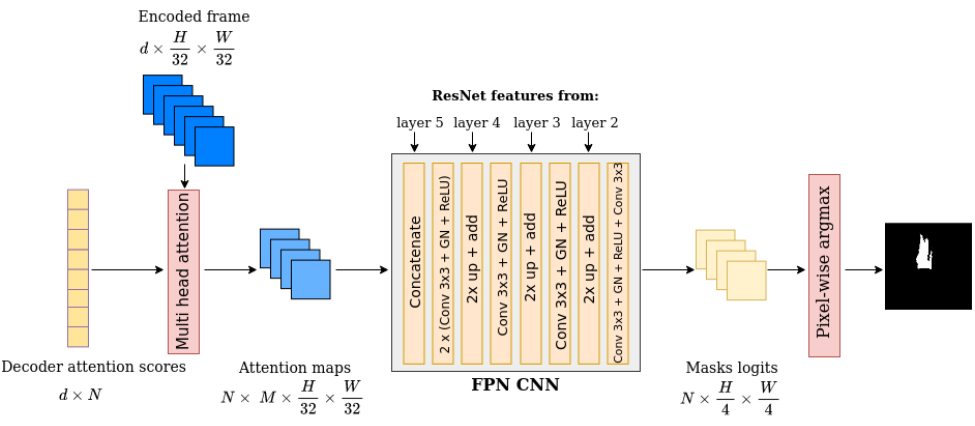
Figure 6. In this figure, the mask head architecture is depicted. All the steps from the decoder attention scores, until the final segmentation mask, are